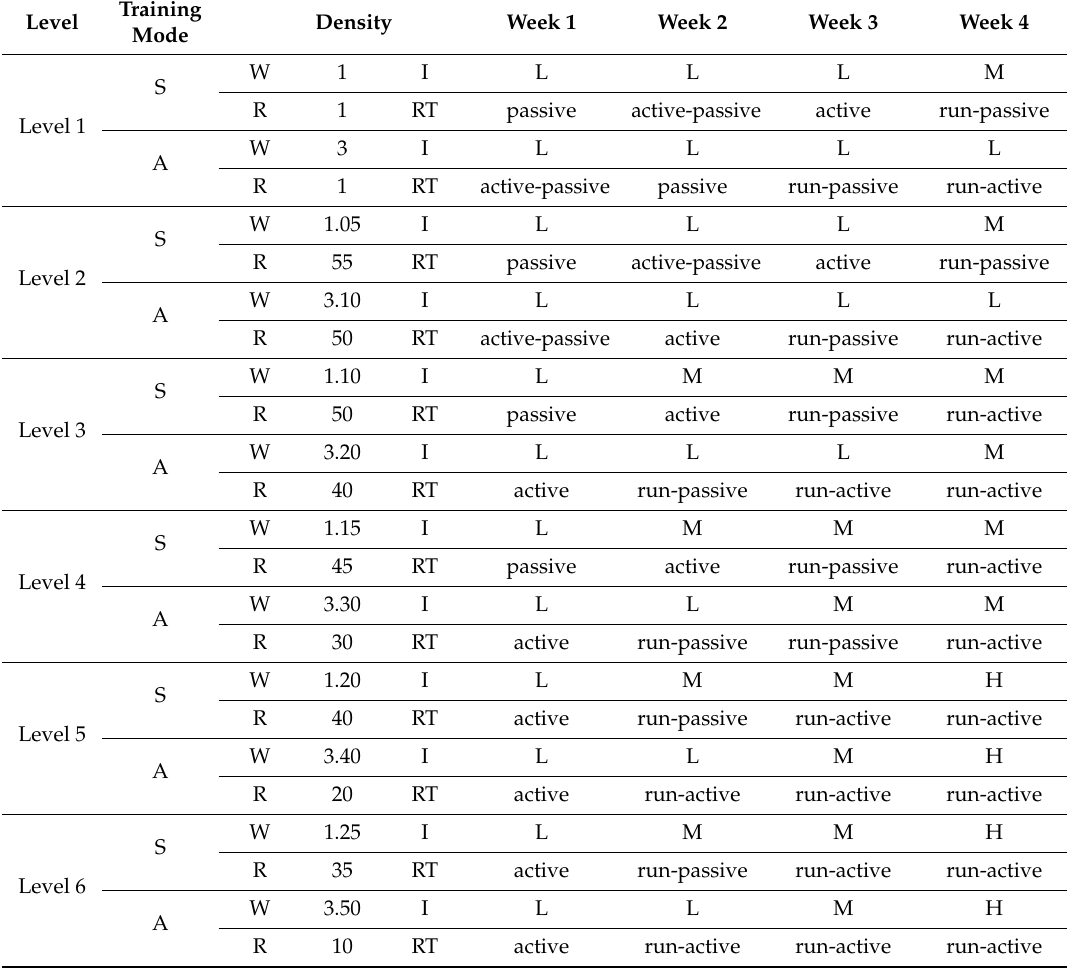
Table 2. Training progression for Activa Murcia 6